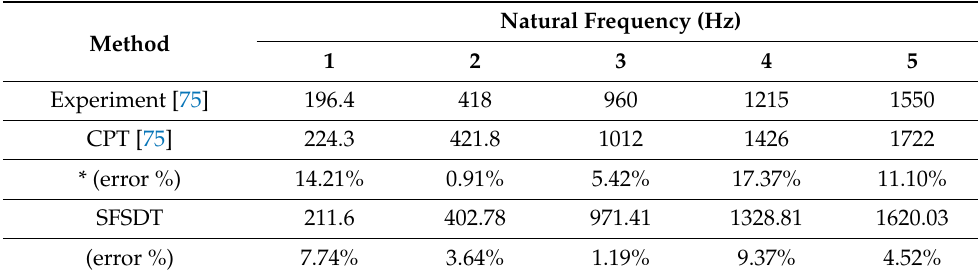
Table 4. Natural frequencies of graphite/epoxy [0, 45, − 45, 90] s square cantilever plate ( a = 76.2 mm, a / h = 73.2).